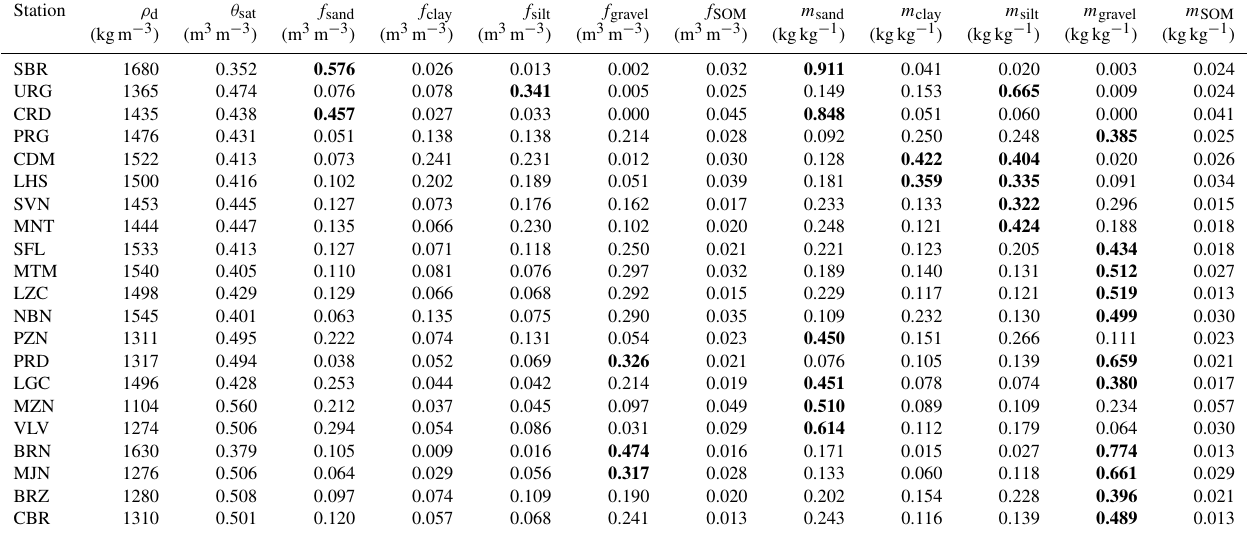
Table 1. Soil characteristics at 10cm for the 21 stations of the SMOSMANIA network. Porosity values are derived from Eq. (1). Solid fraction values higher than 0.3 are in bold. The stations are listed from west to east (from top to bottom). ρ d , θ sat , f and m stand for soil bulk density, porosity, volumetric fractions and gravimetric fractions, respectively. Soil particle fractions larger than 0.3 are in bold. Full station names are given in Supplement 1 (Table